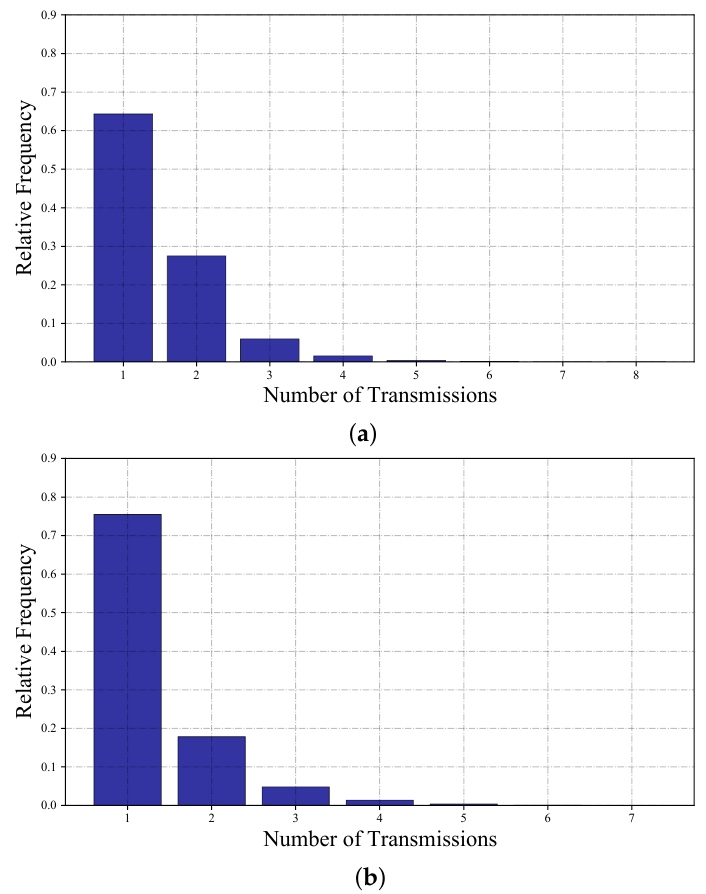
Figure 6. Distribution of the number of transmissions for T8: ( a ) ILP [17] and ( b ) INLP. Note that the mote output module of the Cooja emulator can display the E2E delay of each node. We observe that the requirement of user-defined synchronization accuracy, which is translated into the E2E delay of 6 seconds, is met for all of the cases considered, as shown in Table 9. Table 9. End-to-end delay